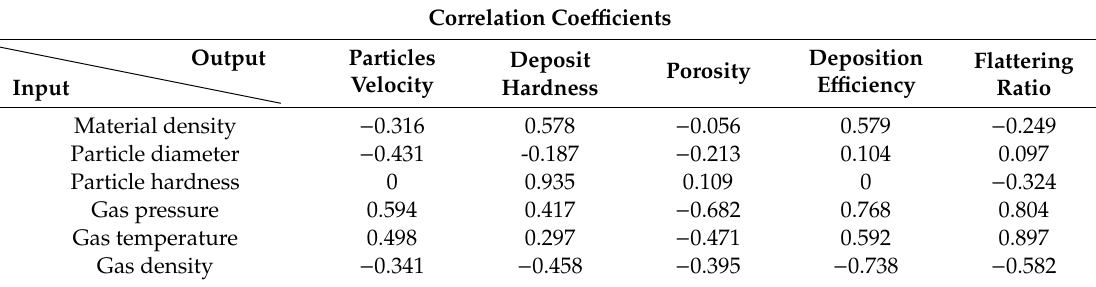
Table 5. Correlation behavior among the di ff erent input / output.